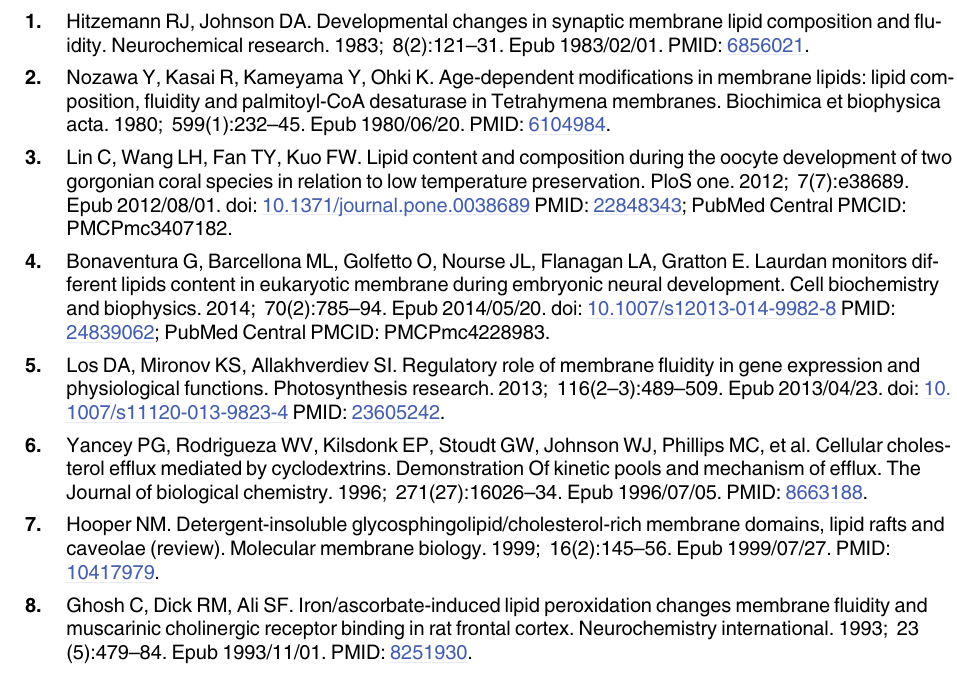
S10 Fig. Laurdan GP analysis in 72 h old L6 cells. A) Fluorescence-intensity images of three L6 cells at 72 h observed in the blue channel (460 – 480). GP scale to pseudo color the intensity image is shown at the right. C) GP histogram from the corresponding image in B). One Gauss- ian component is observed referring to the cell membrane after digital mask application. Aver- age GP = 0.152. The width at half maximum is ~ 0.25. S11 Fig. Laurdan GP analysis in 92 h old L6 cells. A) Fluorescence-intensity images of three L6 cells at 92 h observed in the blue channel (460 – 480).GP scale to pseudo color the intensity image is shown at the right. C) GP histogram from the corresponding image in B). One Gauss- ian component is observed referring to the cell membrane after digital mask application. Aver- age GP = 0.225. The width at half maximum is ~